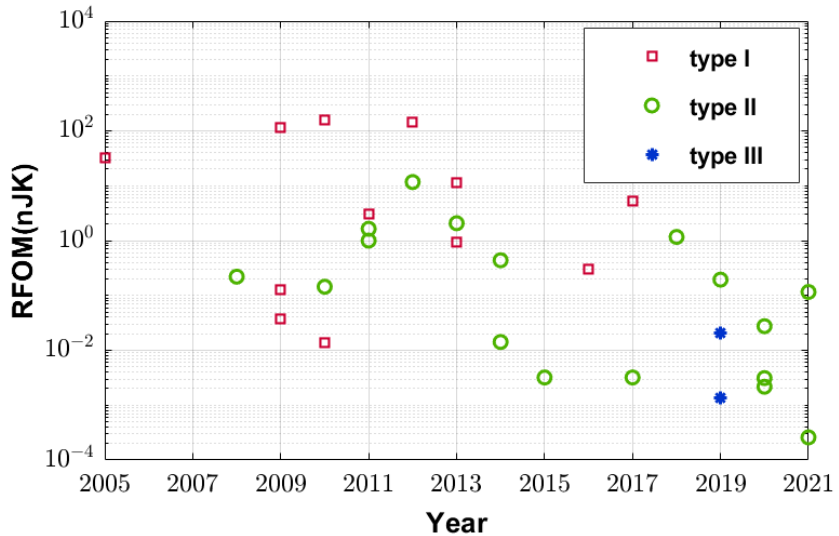
Figure 10. Resolution figure of merit (RFOM, log scale) versus the year of publication, for all three types of MOS-based temperature sensors, along with the trend for type I and II. The RFOM is calculated as the energy/conversion · resolution 2 and is a measure of energy efficiency in reference to its resolution.